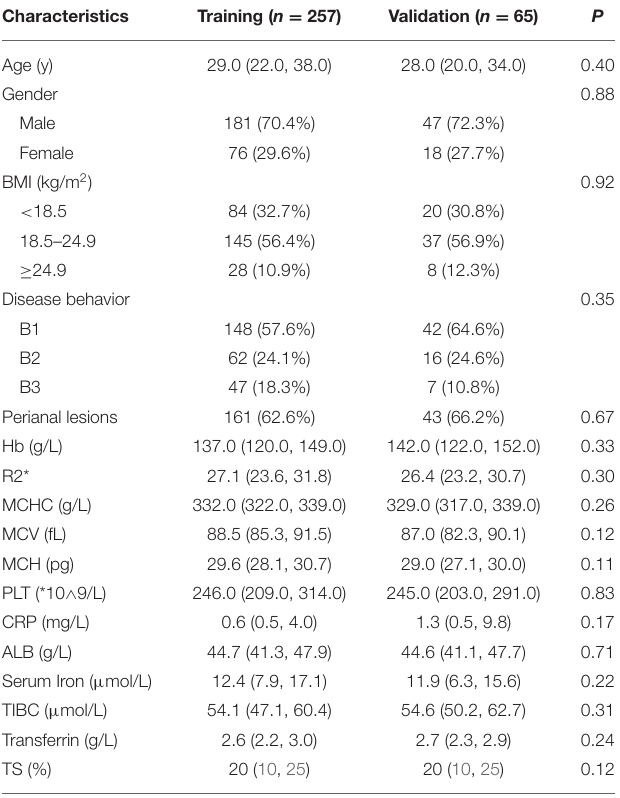
TABLE 1 | Patient demographics and clinical characteristics. Characteristics